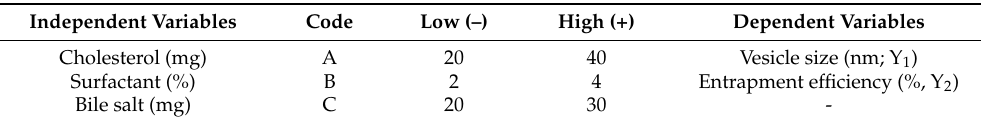
Table 1. Selected formulation variables at different levels for the optimization of miconazole bilo- somes (MZBSs).